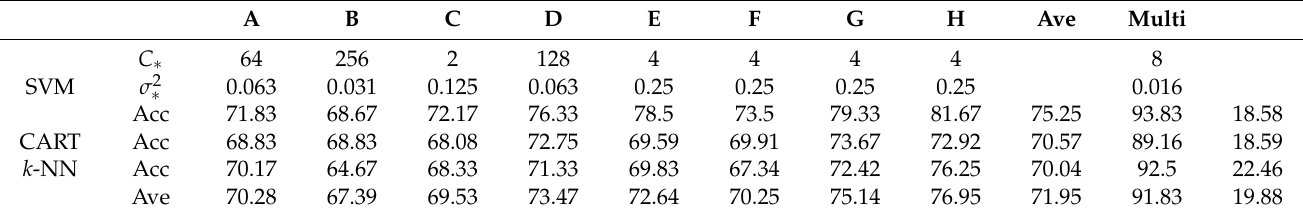
Table 10. Testing results for single-segment features and multi-segment features.